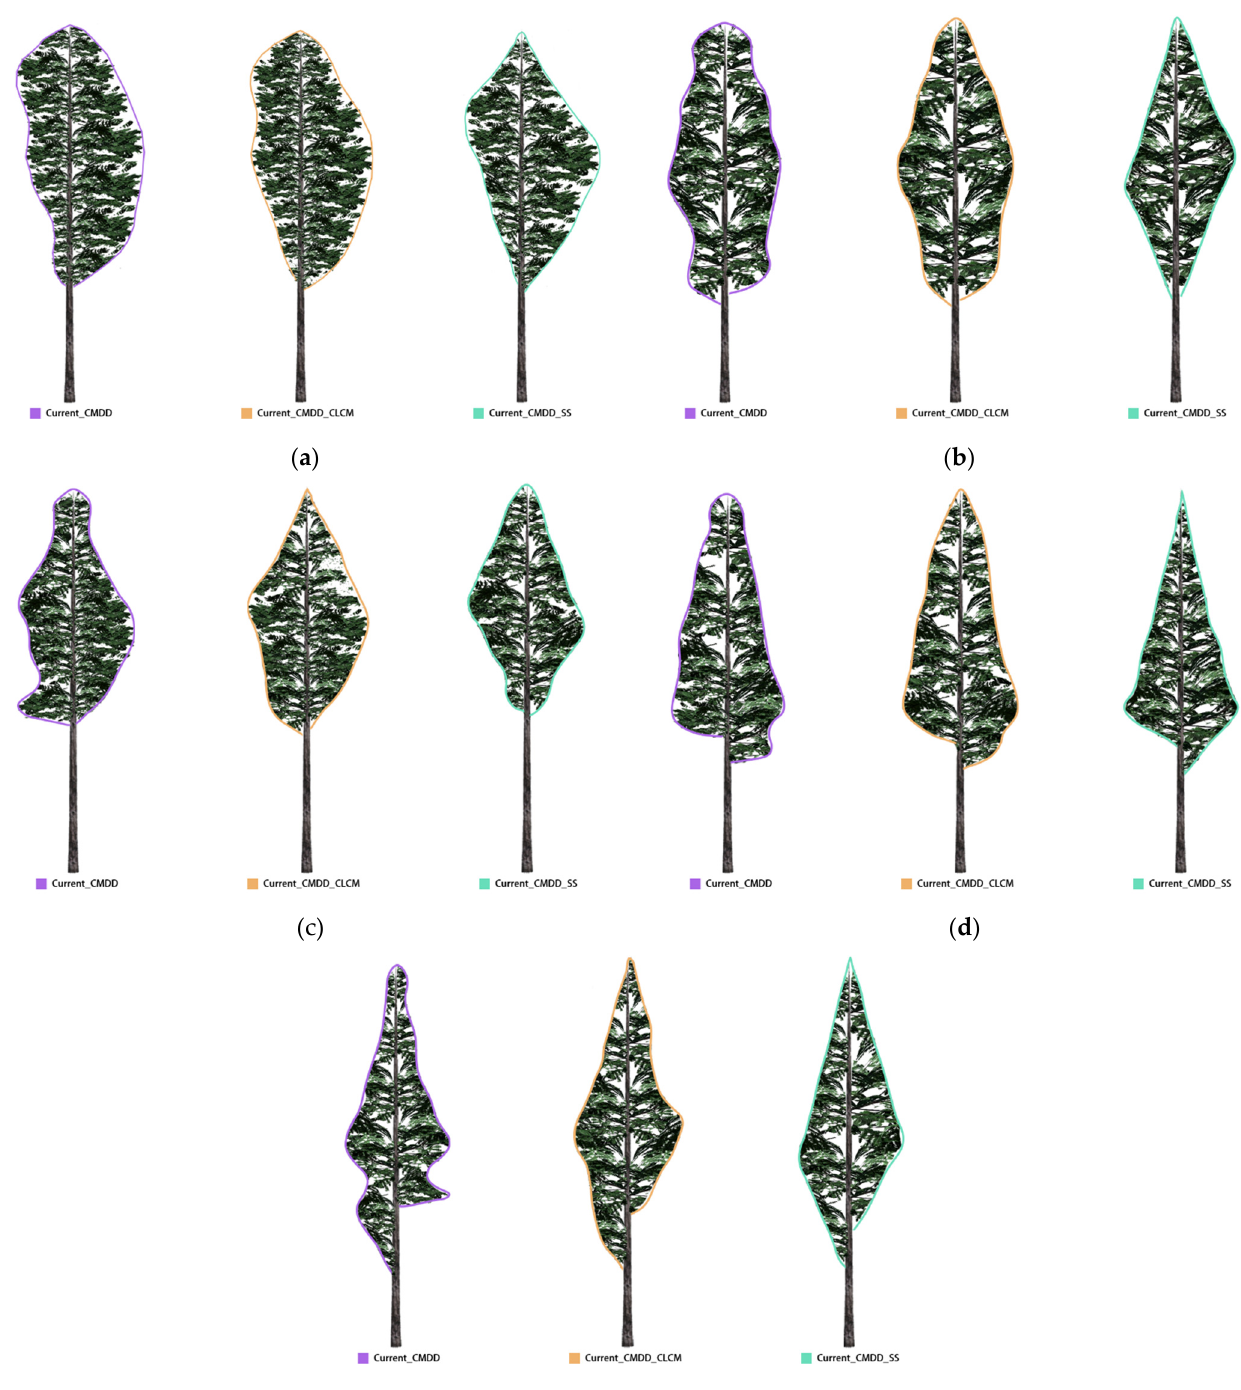
Figure 10. Identifying differences in 3D fir models from different methods with a height of ( a ) 10 m; ( b ) 12 m; ( c ) 14 m; ( d ) 16 m; and ( e ) 18 m. ( b ) 12 m; ( c ) 14 m; ( d ) 16 m; and ( e ) 18